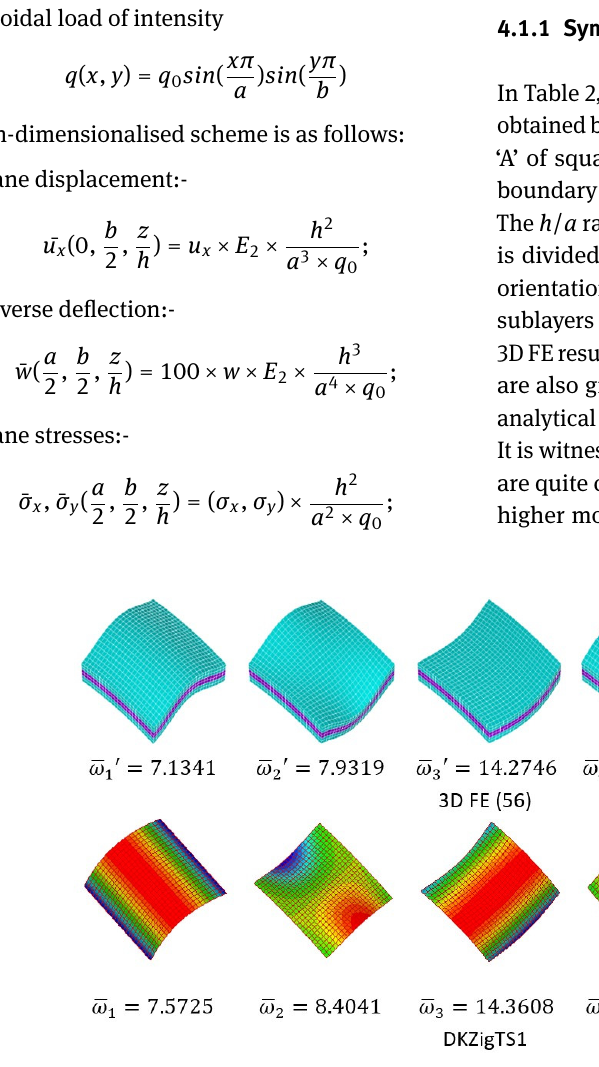
Figure 7: Comparison of first five mode shapes for composite cylindrical shell Panel ‘A’ with CFCF boundary conditions, R / a = 5 and h / a =